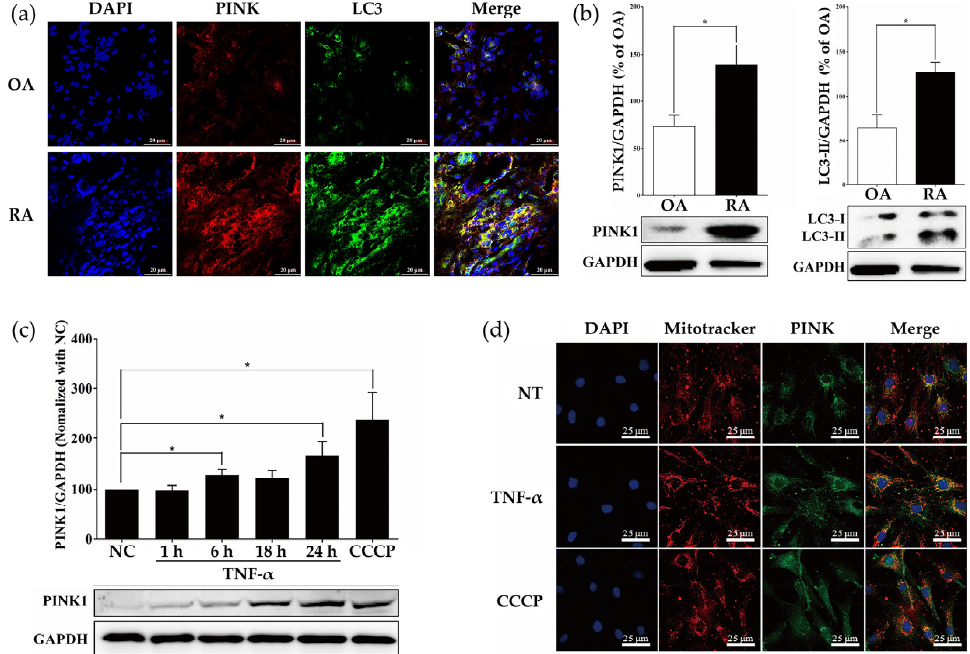
Figure 1. PINK1 is highly expressed in synovial tissues of rheumatoid arthritis patients and TNF- α - treated RASFs. ( a ) Immunofluorescence staining for PINK1 (red), LC3B (green), and nuclei (blue) in synovial membranes of OA and RA patients. Scale bar: 20 µ m. Images are representative of five images/sample; n = 3 samples/disease group. ( b ) Tissue Western blots for PINK1 and LC3B-II in human synovial membranes from OA ( n = 3) and RA ( n = 3) patients. The bar graph shows quantification by densitometry of LC3-II, and PINK1 in synovial membranes from RA and OA patients, presented as means ± SEM ( n = 3 independent patient synovial membranes). * p < 0.05. ( c ) TNF- α (10 ng/mL) induced PINK1 upregulation in a time-dependent manner. RASFs were treated with CCCP (10 μ M) for 24 h. PINK1 protein was detected by immunoblotting. The bar graph shows the quantification of PINK1 expression by densitometry in RASFs, expressed as means ± SEM ( n = 5 independent RASF preparations/group). * p < 0.05. ( d ) Immunofluorescence staining for PINK1 (green), mitochondria (red), and nuclei (blue) in RASFs treated with TNF- α for 24 h. Scale bar: 25 μ m. Image (original magnification, ×100) is representative of five images/slide, n = 3 slides/treatment group.